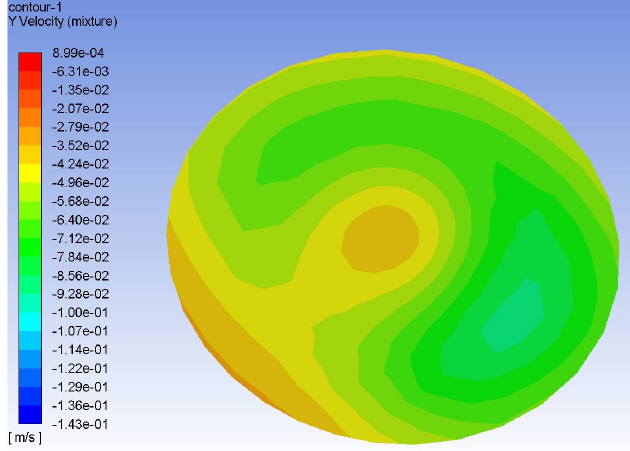
Figure 11. Velocity field simulation diagram at the bottom of the mixing cavity.